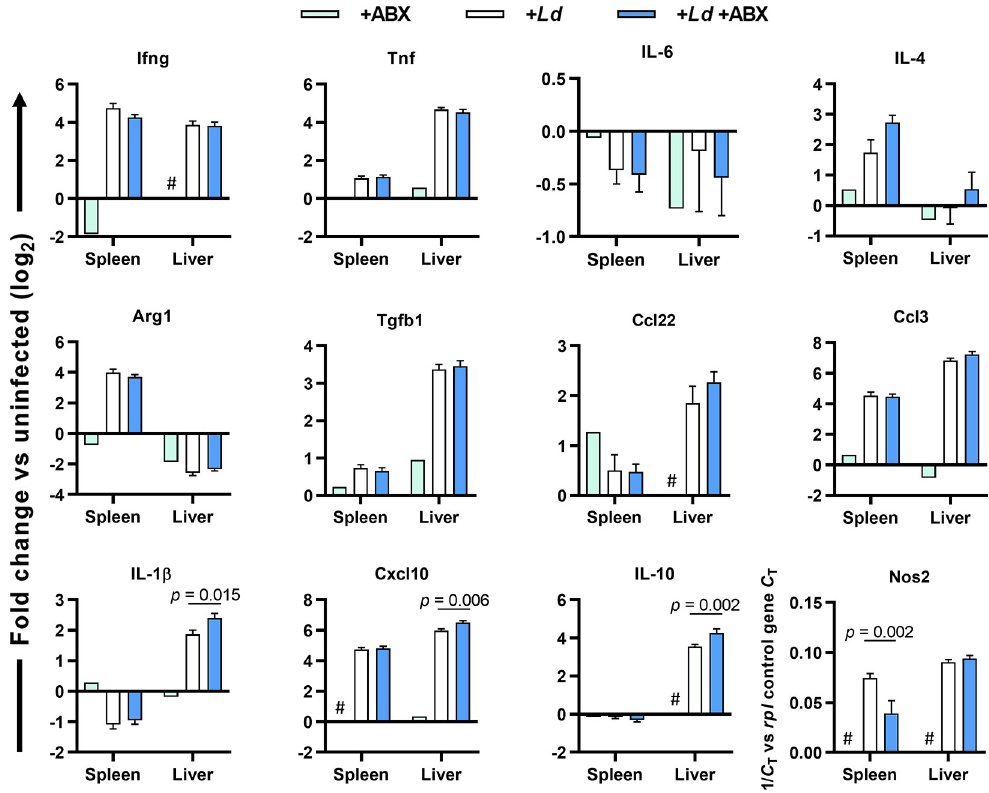
Fig 7. Gene expression analysis in dysbiotic hamsters infected with L . donovani . Hamsters were maintained on drinking water with or without antibiotic cocktail (ABX) and infected with L . donovani (n = 6) or kept na ï ve (n = 1). At 12 weeks post-infection, RNA transcript abundance for the indicated genes in spleen and liver tissue was measured by RT-qPCR with normalisation to Rpl18 . Data are mean +SEM log 2 -transformed fold change in gene expression compared to untreated, uninfected control hamsters (n = 4). # indicates transcript abundance was below detection limit. Differences are indicated when p < 0.05 between groups in t-test.